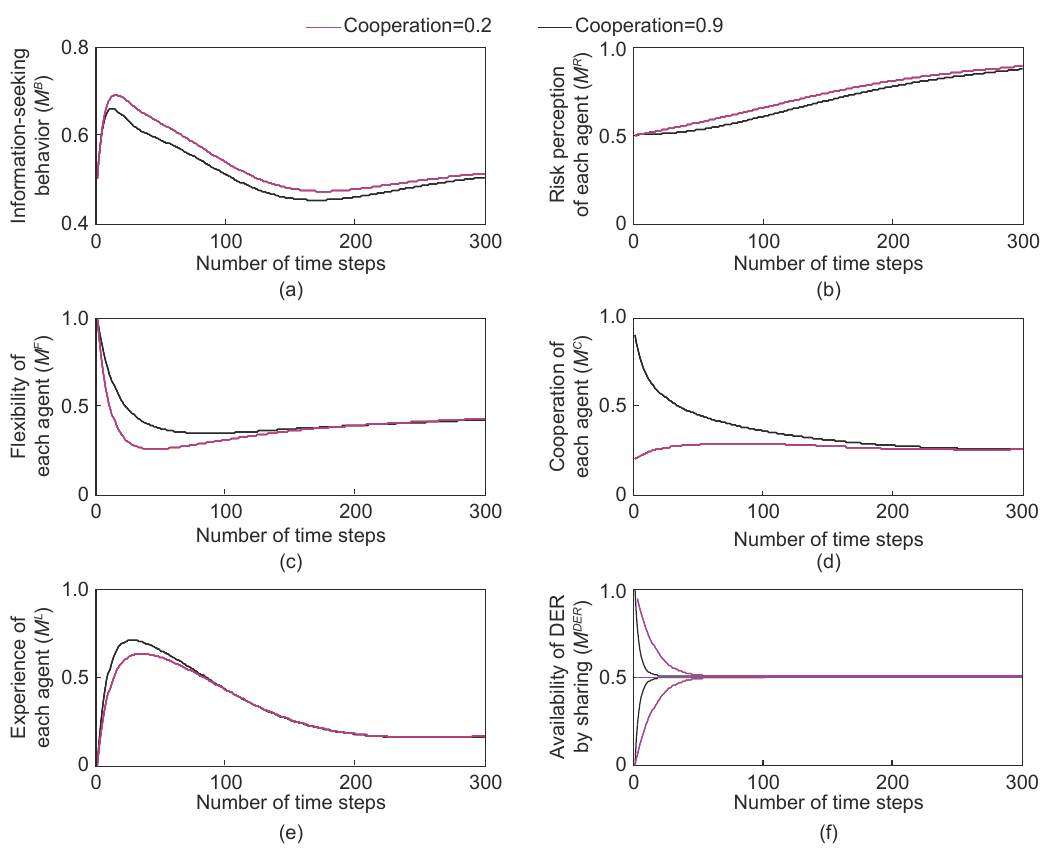
Fig. 5 Effects of cooperation on electricity sharing and the impact of the availability of electricity (and also cooperation) on information-seeking behavior, risk perception, flexibility, and experience. It is assumed that agents have a varying value of accessibility to distributed energy resources, i.e., 0, 0.5, and 1, meaning no, medium, or maximum levels, respectively. The results are provided for initial values of cooperation of 0.2 (low cooperation) and 0.9 (high cooperation).